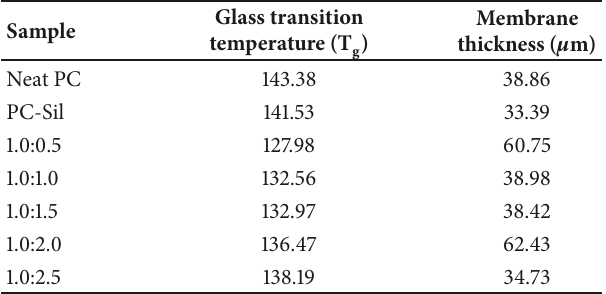
) of prepared membranes. g Glass transition Membrane temperature (T ) thickness ( 𝜇 m) g